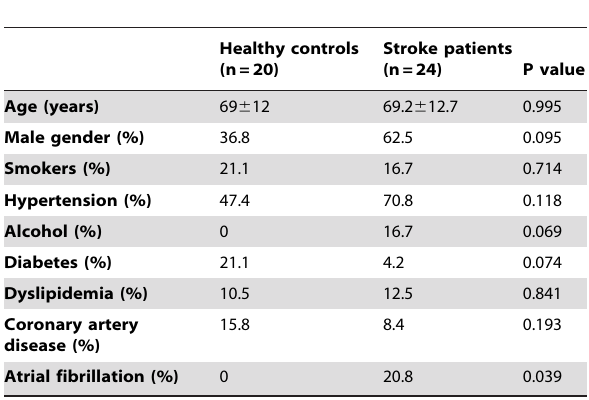
Table 2. Demographic features of stroke patients and healthy